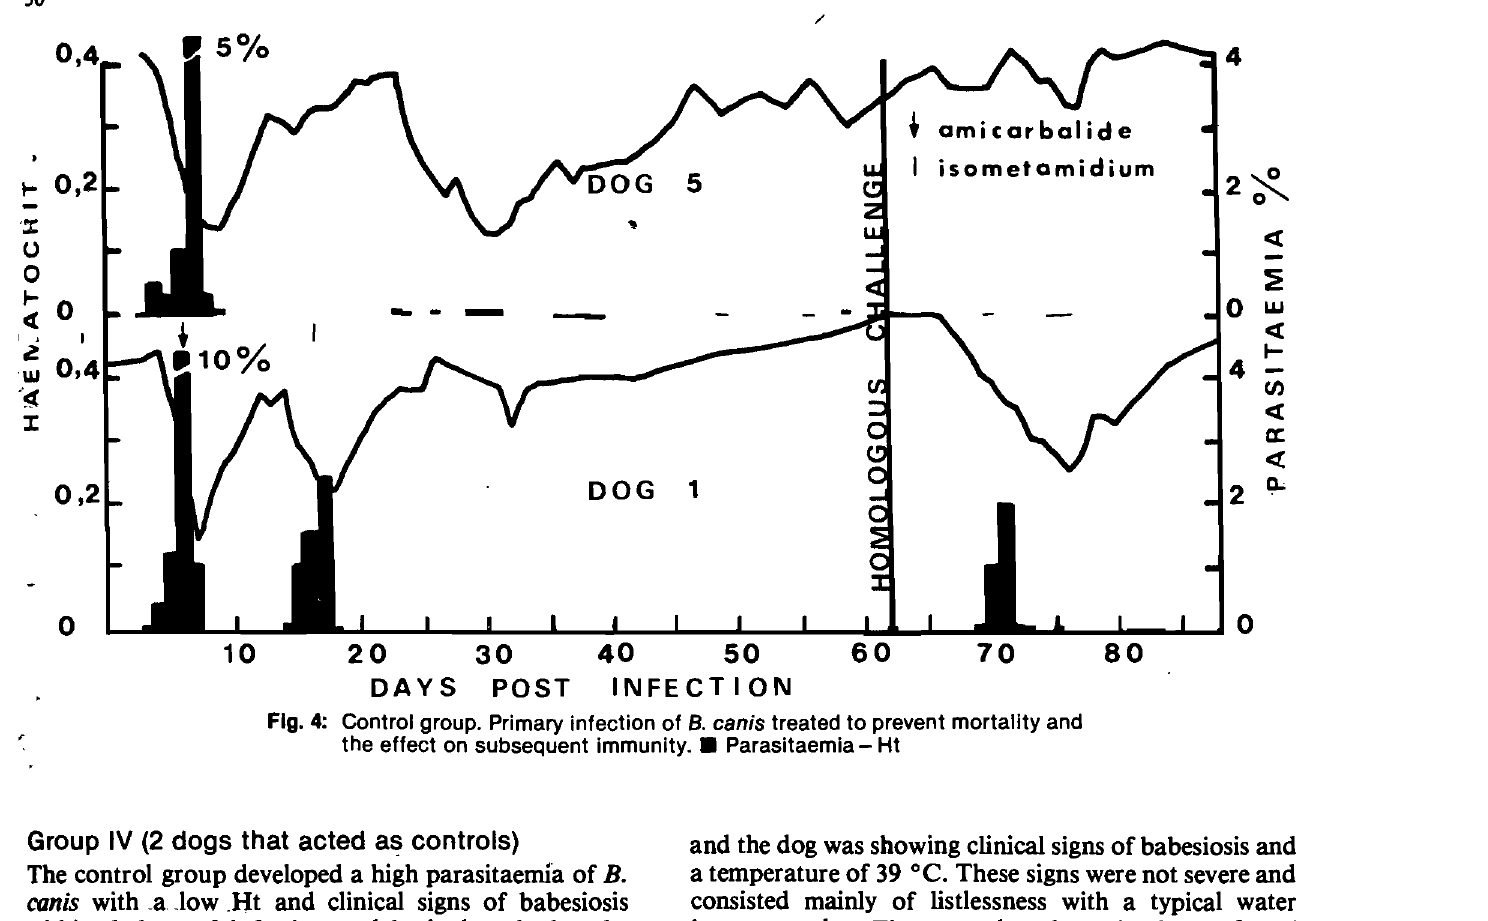
Table 1: BABESIA CANIS INFECTION IN